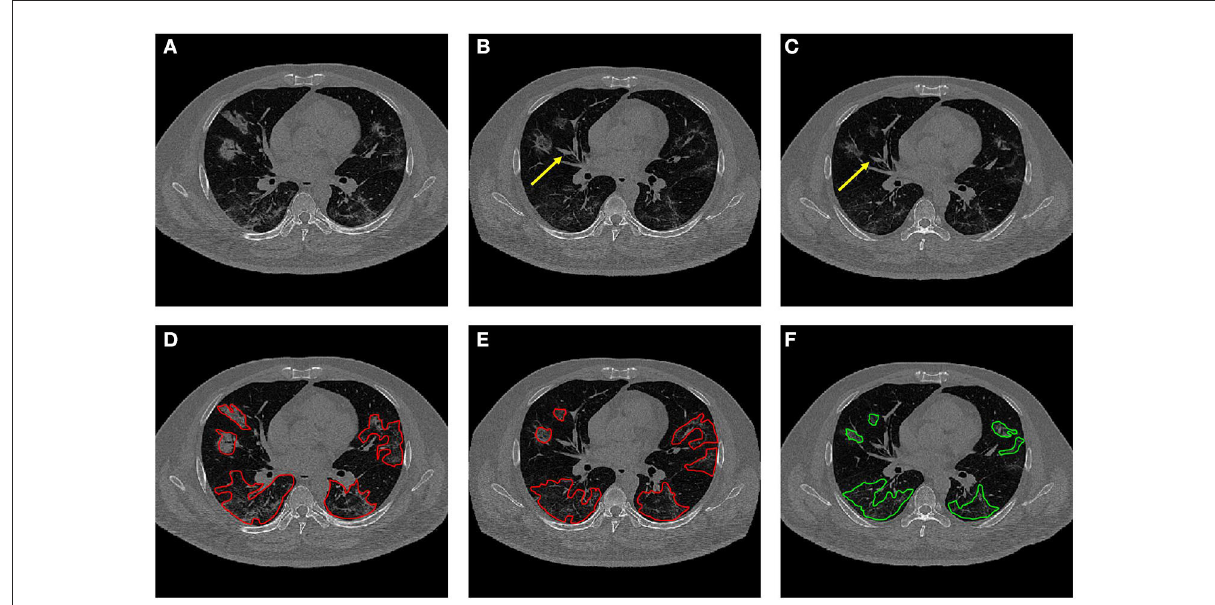
FIGURE6 Dynamic changes of CT imaging in a 42-year-old male patient. (A) Baseline image. (B) The transformed baseline image to match the F/U after completing the two-step Affine and Demons algorithms. (C) The first F/U image. In (B,C) , it is noted that the vascular structures are better matched (yellow arrows). (D) The baseline CT with original lesion ROI. (E) The transformed CT with the mapped lesion ROI serves as the reference for the second-look ROI redrawing. (F) The original ROI on the first F/U